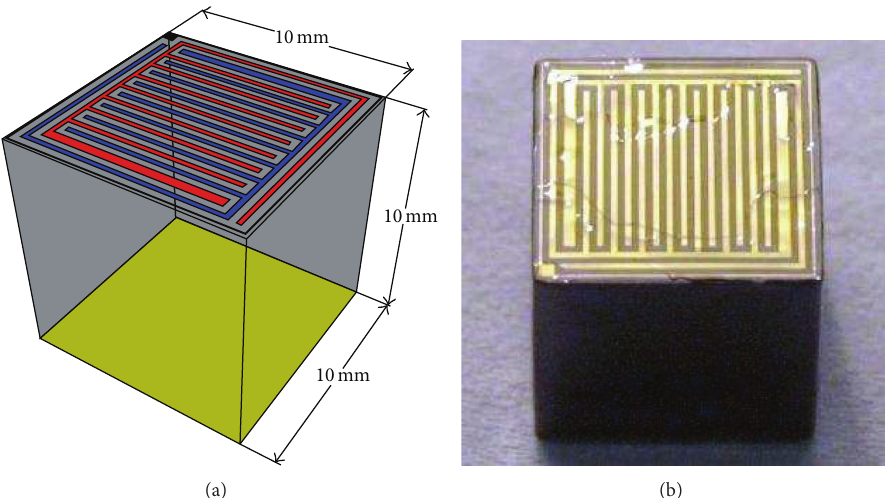
Figure 3: (a) Diagram of CPG detector indicating the anode grids (blue and red) and the cathode (yellow). (b) Photograph of a COBRA detector.